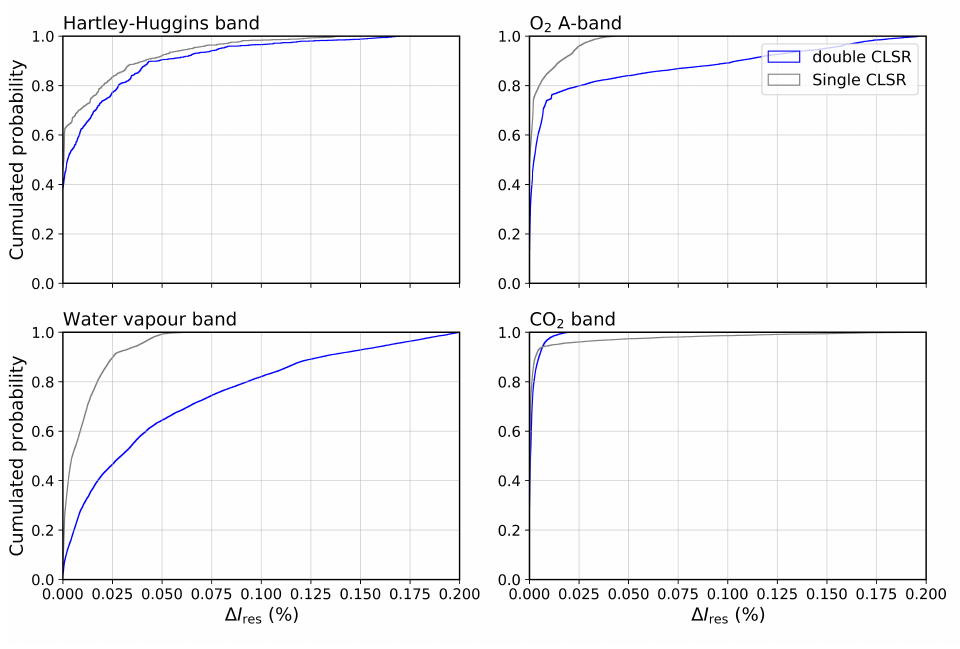
Figure 5. Same as Figure 4, but for the cumulated probability of the residuals.